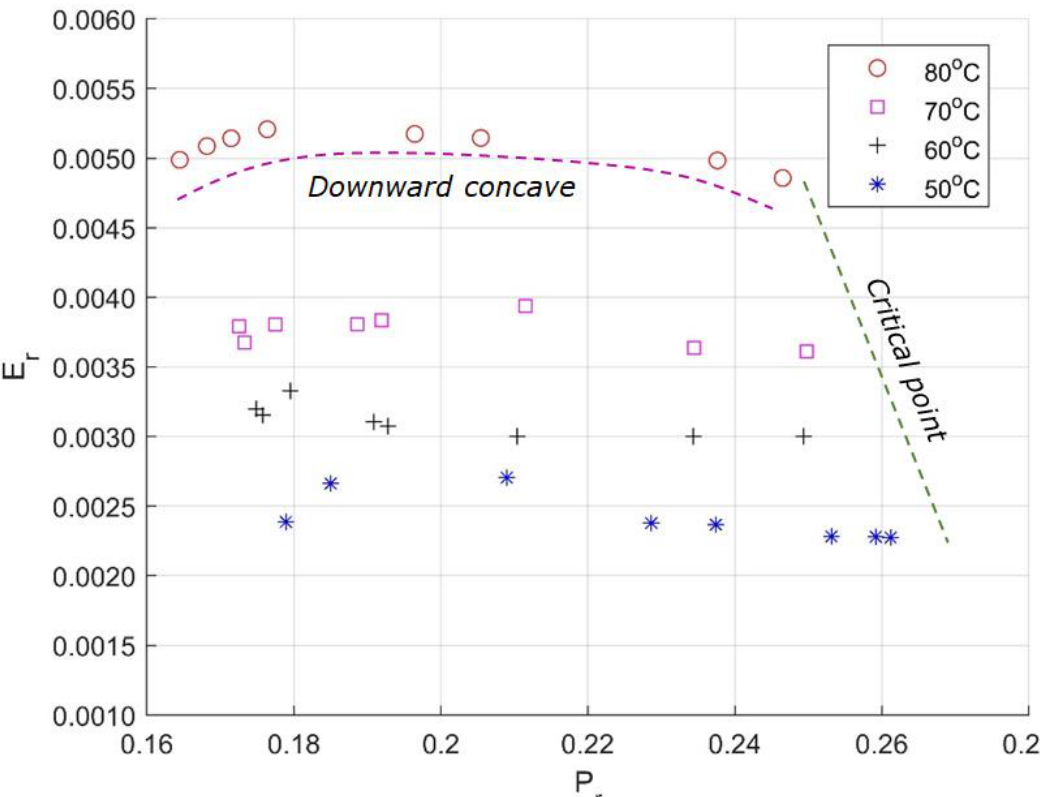
Figure 10. Performance of the eductor; entrainment ratio, E r , vs pressure ratio, P r .